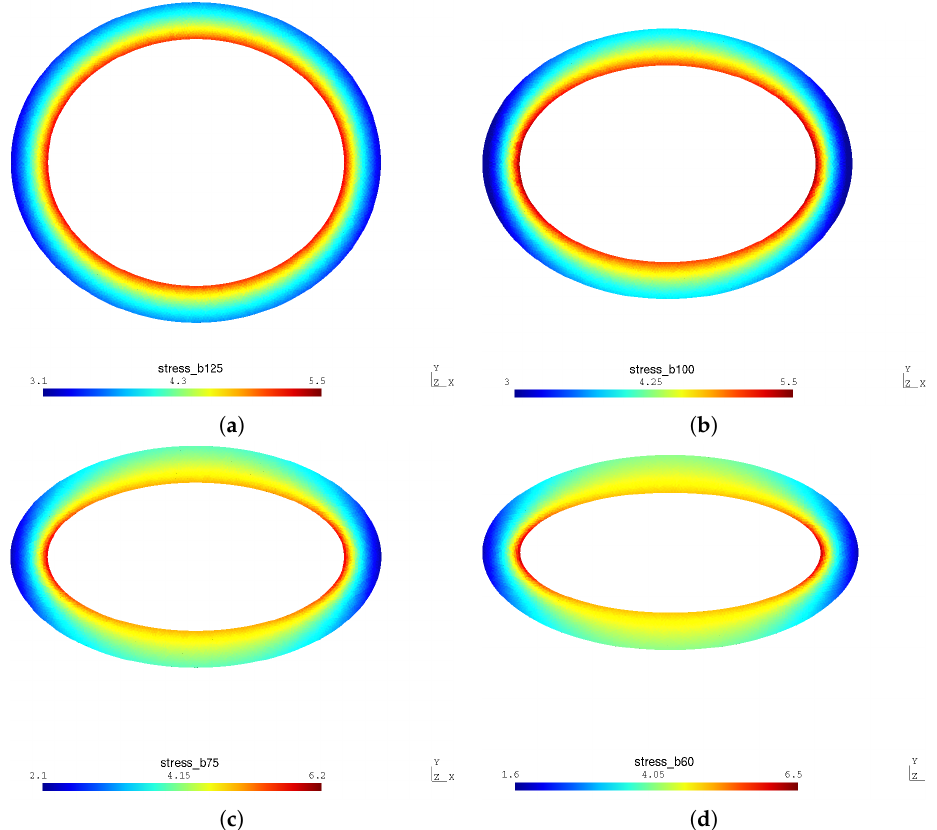
Figure 5. View from the top: von Mises stress (in MPa) contour of the concrete elliptical rings. Note that the color-map limits are not unified for all cases to better represent the stress concentration. ( a )